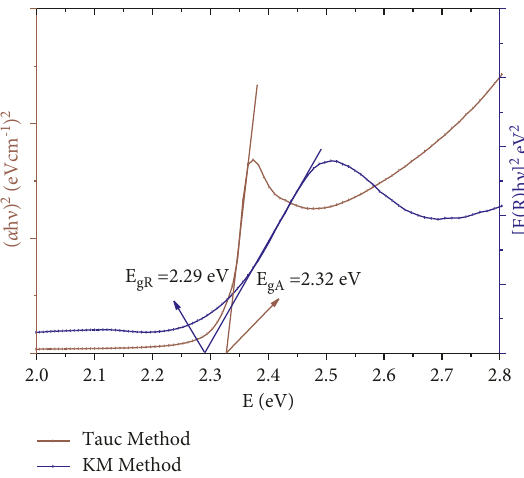
Figure 9: Bandgap estimation via the Tauc and KM